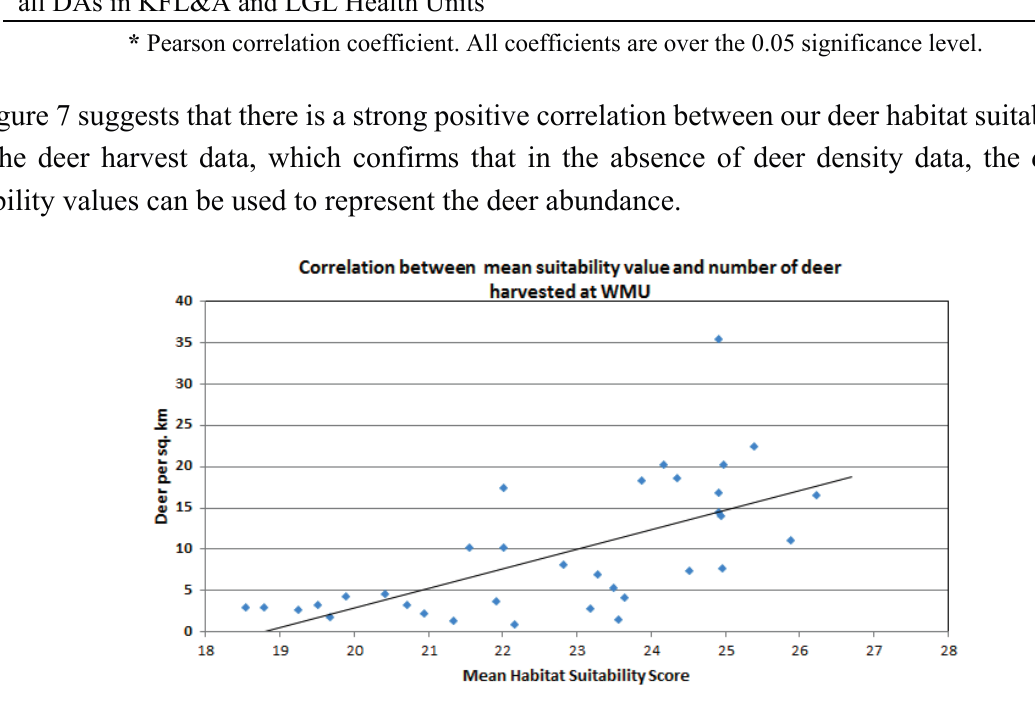
Figure 7. Correlation between the mean habitat suitability value and adjusted number of deer harvested in the WMU. The p -value is less than